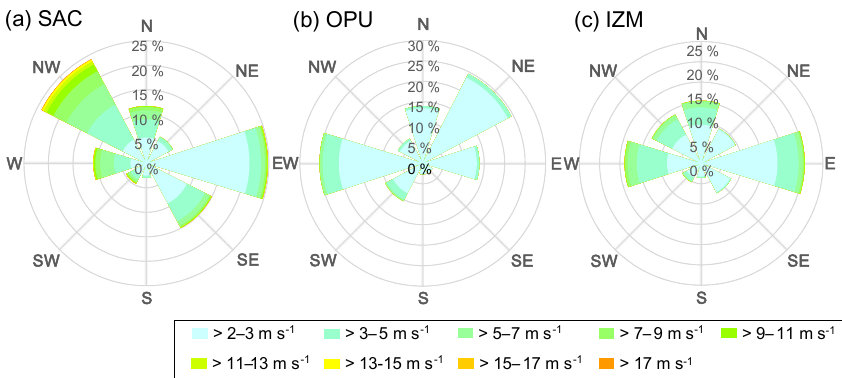
Figure 3. Relative wind frequency distributions at the three sites during the study period in 2015. Data are binned in 45 ◦ classes.